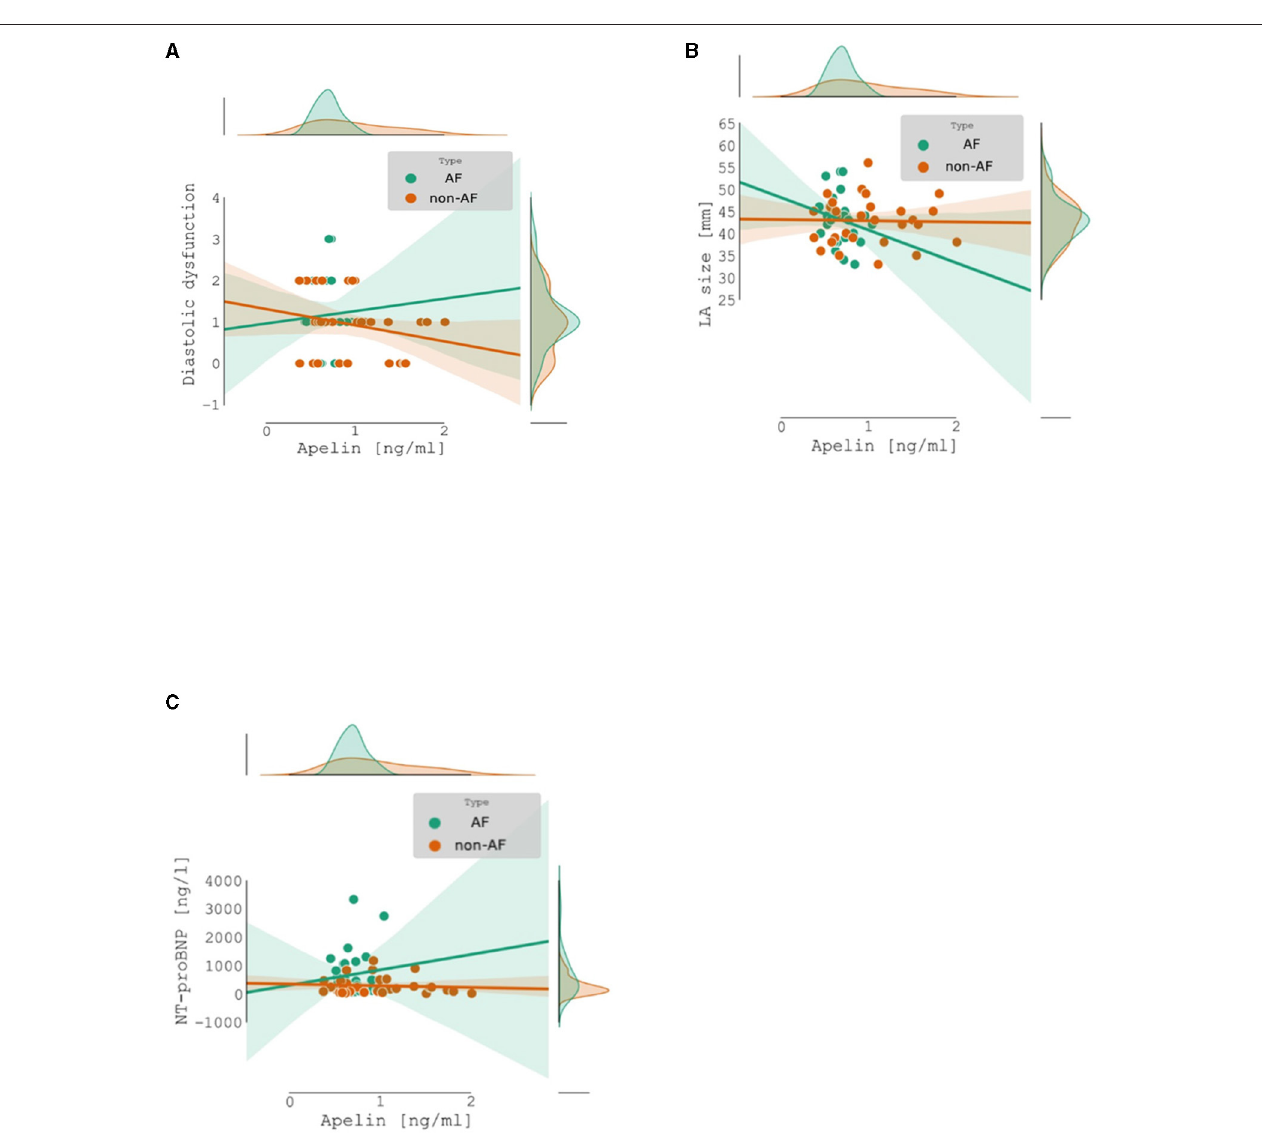
FIGURE 2 | Apelin concentration: Non-atrial fibrillation patients (no-AF) vs. atrial fibrillation patients (AF): (A) correlation between apelin concentration and diastolic dysfunction; (B) correlation between apelin concentration and left atrium diameter; (C) correlation between apelin concentration and NT-proBNP.